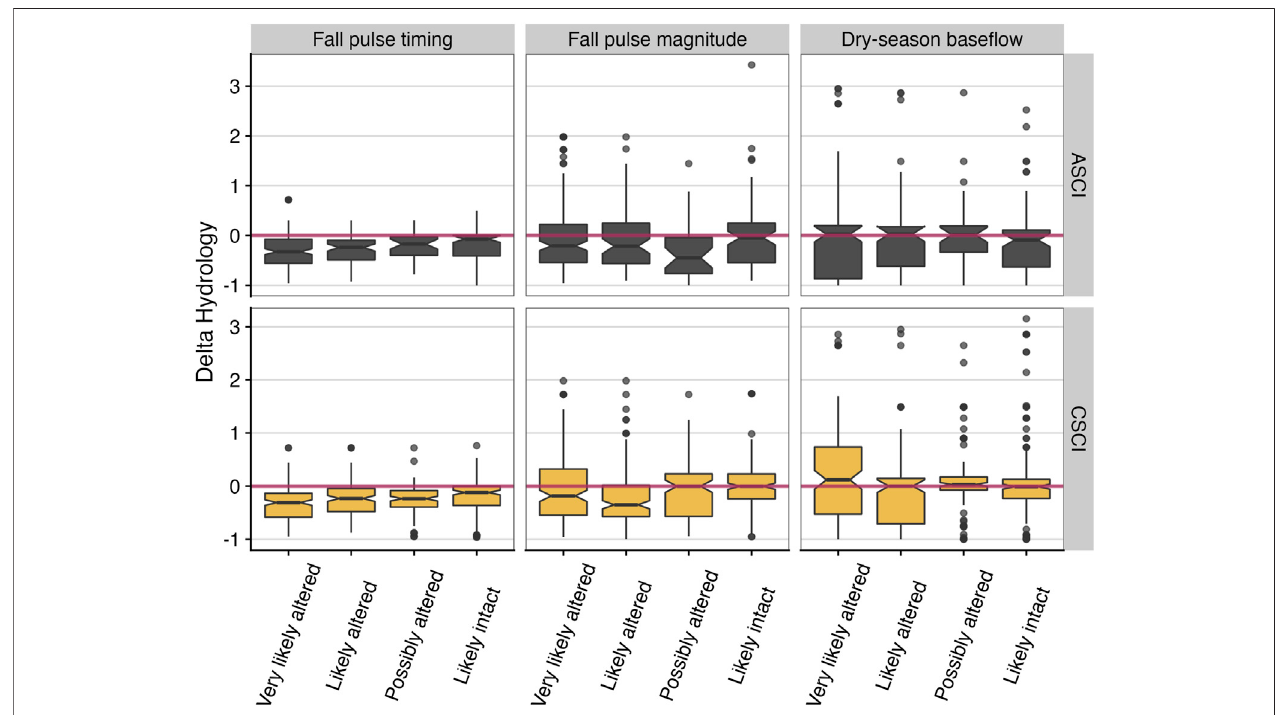
FIGURE 6 | In fl uential functional fl ow metric values (normalized as delta hydrology) versus binned ASCI and CSCI values (based on thresholds from Mazor et al. (2016) and Theroux et al. (2020) for all paired sites across California. The red zero line delineates departure from expected reference fl ow metric, where values < 0 are reduced or early, and values > 0 are in fl ated or late, relative to the expected reference value. Notches indicate an approximate 95% con fi dence interval to compare medians, where if notches of two boxplots do not overlap, this suggests the medians are signi fi cantly different (see McGill et al. (1978).